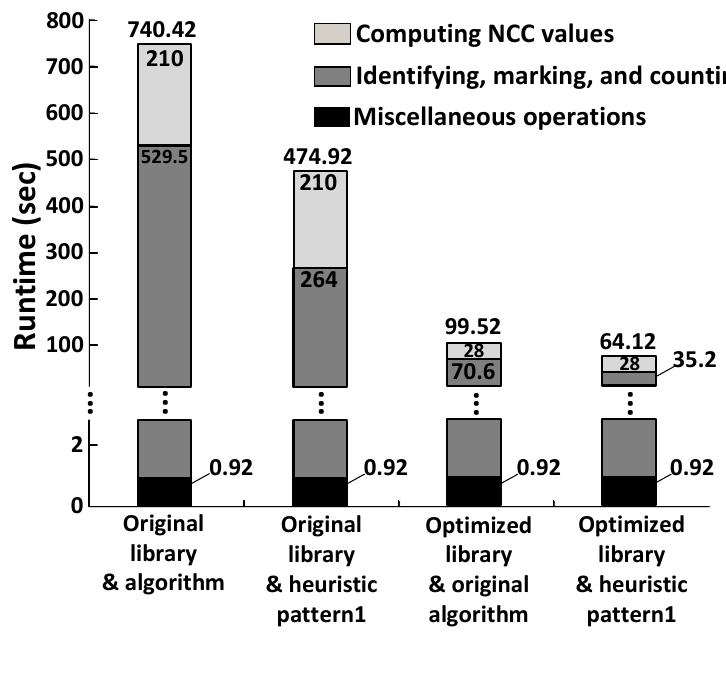
Figure 8. The runtime of the original algorithm and the optimized algorithms employing either or both of an optimized cell library to minimize the number of cell images and heuristic Pattern 1 to skip NCC computations for some points. The runtime of the original algorithm that evaluates NCC values for each and every point is, on average, 740.42 s, while that of the optimized algorithm is only 64.12 s, achieving almost a 11 . 5 × runtime reduction with accuracy loss less than 1%. The result also demonstrates that the cell library optimization reduces the runtime by 86.6% (from 740.42 s to 99.52 s), while heuristic Pattern 1 contributes to a 50.1% runtime reduction (from 529.5 s to 264